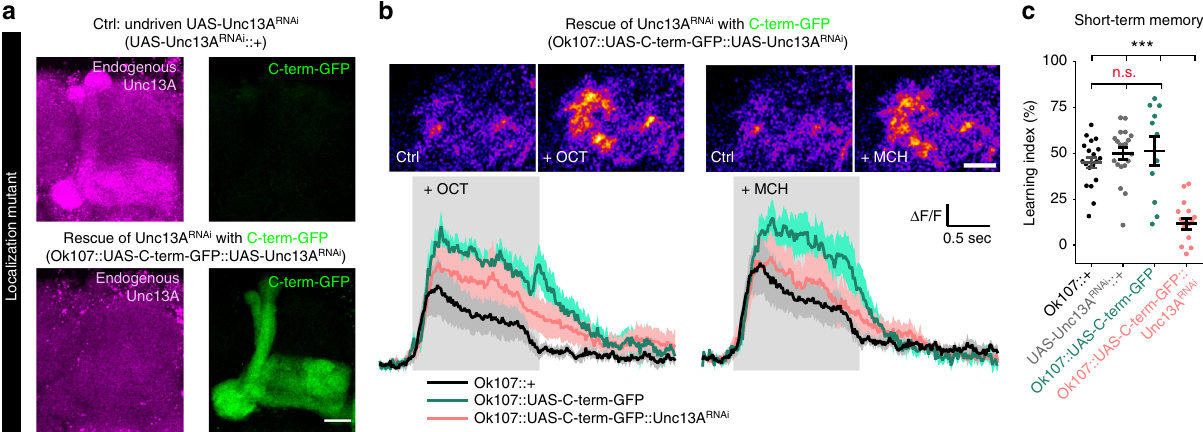
Fig. 7 Mutants incapable of PHP impair short-term memory. a Confocal images of adult Drosophila mushroom-body regions of control (top; undriven UAS- Unc13A RNAi (UAS-Unc13A RNAi :: + )) and rescue of driven UAS-Unc13A RNAi with C-term-GFP (bottom; Ok107::UAS-C-term-GFP::UAS-Unc13A RNAi ) brains labelled with the indicated antibodies. b Averaged odor responses measured at the level of presynaptic boutons of M4/6 (MBON- β ‘ 2 mp/MBON- γ 5 β ′ 2a/ MBON- β 2 β ′ 2a) mushroom body output neurons (compare ref. 54 or ref. 89 ). Above: sample images of two-photon recordings from M4/6 cells (20 frames averaged respectively) before and after odor onset. Grey shading indicates the time at which the odor was applied. Left panels OCT and right MCH response. Below: averaged odor responses. Five responses per odor were averaged per animal. Solid lines show mean responses ( n = 5 – 6 animals per genotype). Shaded areas represent the SEM. c Short-term memory scores after mushroom body-speci fi c C-term-GFP rescue after Unc13A downregulation via locally driven RNAi expression (Ok107::UAS-C-term-GFP::Unc13A RNAi ) compared to controls expressing the driver, but not the RNAi (Ok107:: + ), the RNAi without driver (UAS-Unc13A RNAi :: + ) or mushroom body-speci fi c overexpression of the C-term-GFP construct (Ok107::UAS-C-term-GFP). See also Supplementary Fig. 9. Source data as exact raw values, detailed statistics including sample sizes and P values are provided in the Source Data fi le. Scale bars: a 20 µ m; b 10 µ m. Statistics: nonparametric one-way analysis of variance (ANOVA) test, followed by a Tukey ’ s multiple comparison test. *** P ≤ 0.001; n.s., not signi fi cant, P > 0.05. All panels show mean± s.e.m. For representative images experiments were repeated twice with at least 6 – 7 brains per